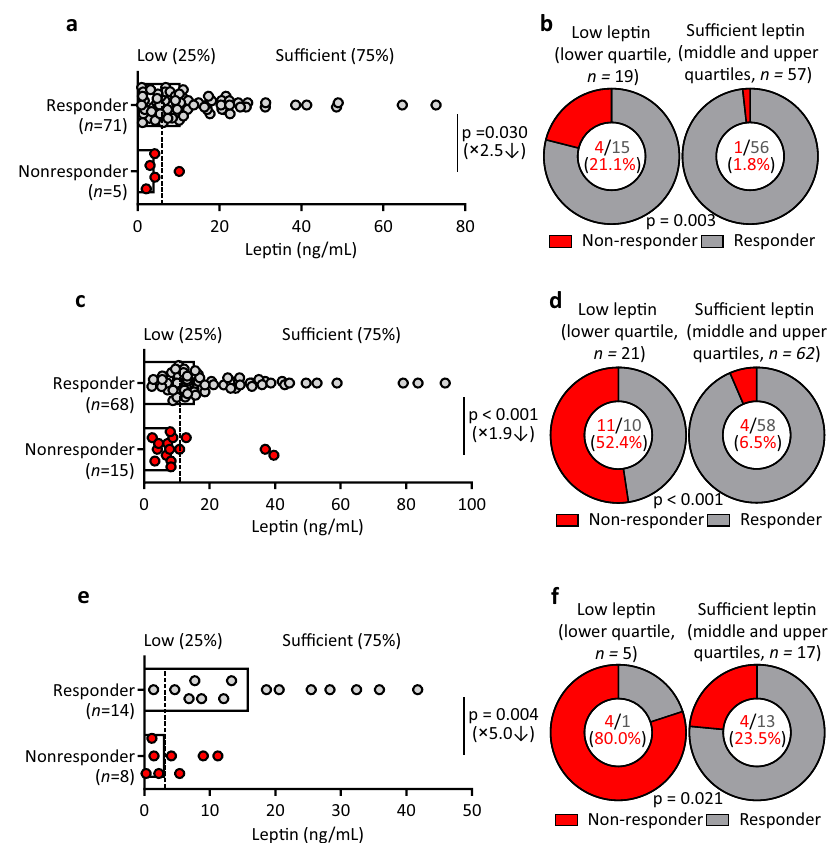
Fig. 1 Low leptin levels are associated with lower antibody responses after vaccination in the general population. a Comparison of serum leptin levels between responders ( n = 71, grey) and non-responders ( n = 5, red) in healthy adults (18 – 60 years, n = 76) immunized with the in fl uenza vaccine. Dotted line indicates healthy individuals with low leptin levels (lower 25%, <4.8 ng/mL) and suf fi cient leptin levels (higher 75%, ≥ 4.8 ng/mL). b Comparison of response rates between low leptin ( n = 19) and suf fi cient leptin ( n = 57) groups. c Comparison of serum leptin levels between responders ( n = 68, grey) and non-responders ( n = 15, red) in healthy elderly adults (>65 years, n = 83) immunized with the in fl uenza vaccine. Dotted line indicates healthy individuals with low leptin levels (lower 25%, <8.8 ng/mL) and suf fi cient leptin levels (higher 75%, ≥ 8.8 ng/mL). d Comparison of response rates between low leptin ( n = 21) and suf fi cient leptin ( n = 62) groups. e Comparison of serum leptin levels between responders ( n = 14, grey) and non-responders ( n = 8, red) in healthy young adults (18 – 25 years, n = 22) immunized with the HBV vaccine. Dotted line indicates healthy individuals with low leptin levels (lower 25%, <3.2 ng/mL) and suf fi cient leptin levels (higher 75%, ≥ 3.2 ng/mL). f , Comparison of response rates between low leptin ( n = 8) and suf fi cient leptin ( n = 14) groups. Data from individuals (dots) and the median values (bars) are shown for a , c and e ; Mann – Whitney test was used for analysis ( a , c , e ). Percentages and numbers are shown for b , d and f ; Chi-Square tests were used for analysis ( b , d , f ). Detailed demographics of each cohort are shown in Supplementary Tables 1-3. For correlation of leptin levels and antibody responses see Supplementary Fig.